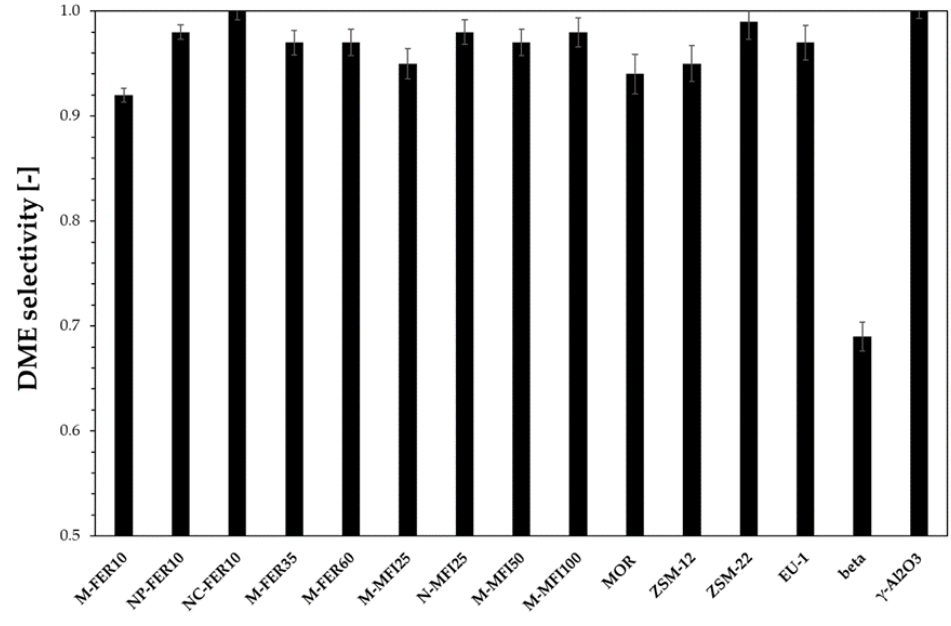
Figure 4. DME selectivity at 240 °C.